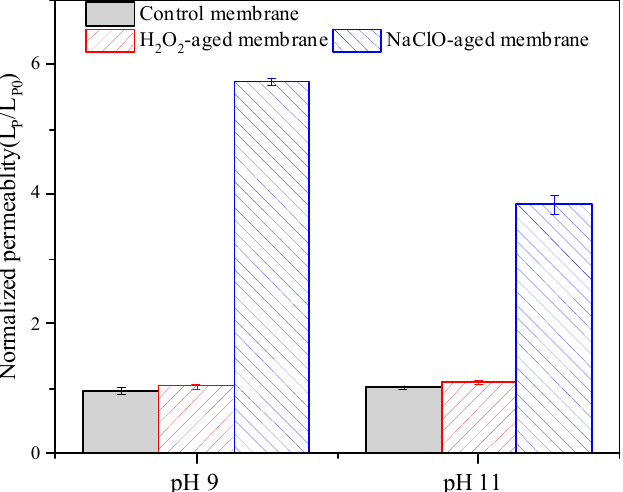
Figure 1. E ff ects of hydrogen peroxide (H 2 O 2 ) and sodium hypochlorite (NaClO) aging on normalized Figure 1. Effects of hydrogen peroxide (H 2 O 2 ) and sodium hypochlorite (NaClO) aging on permeability of polyethersulfone (PES) membrane. Control membrane indicates membrane samples normalized permeability of polyethersulfone (PES) membrane. Control membrane indicates aged in NaOH solution with pH 9 or 11, c(H 2 O 2 ) = c(NaClO) = 5000 mg / L, t = 100 h, and error bars membrane samples aged in NaOH solution with pH 9 or 11, c(H 2 O 2 ) = c(NaClO) = 5000 mg/L, indicate standard deviation of triplicate t = 100 h, and error bars indicate standard deviation of triplicate samples.